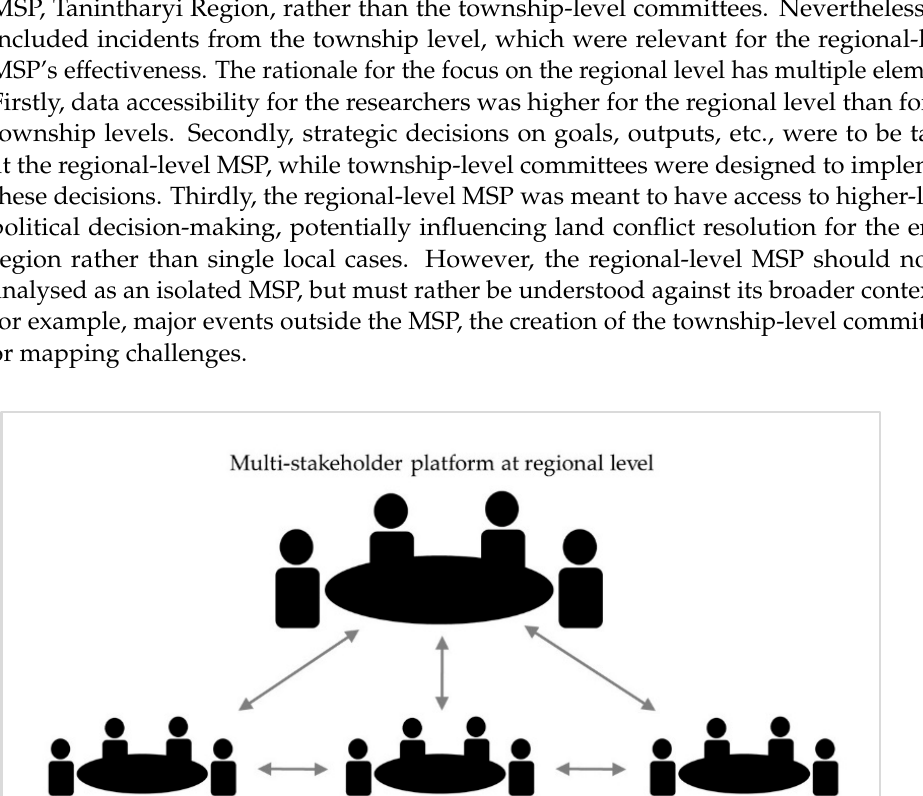
Table 3. Details of data collection (MSP: multi-stakeholder platform, OMM: OneMap Myanmar). Method